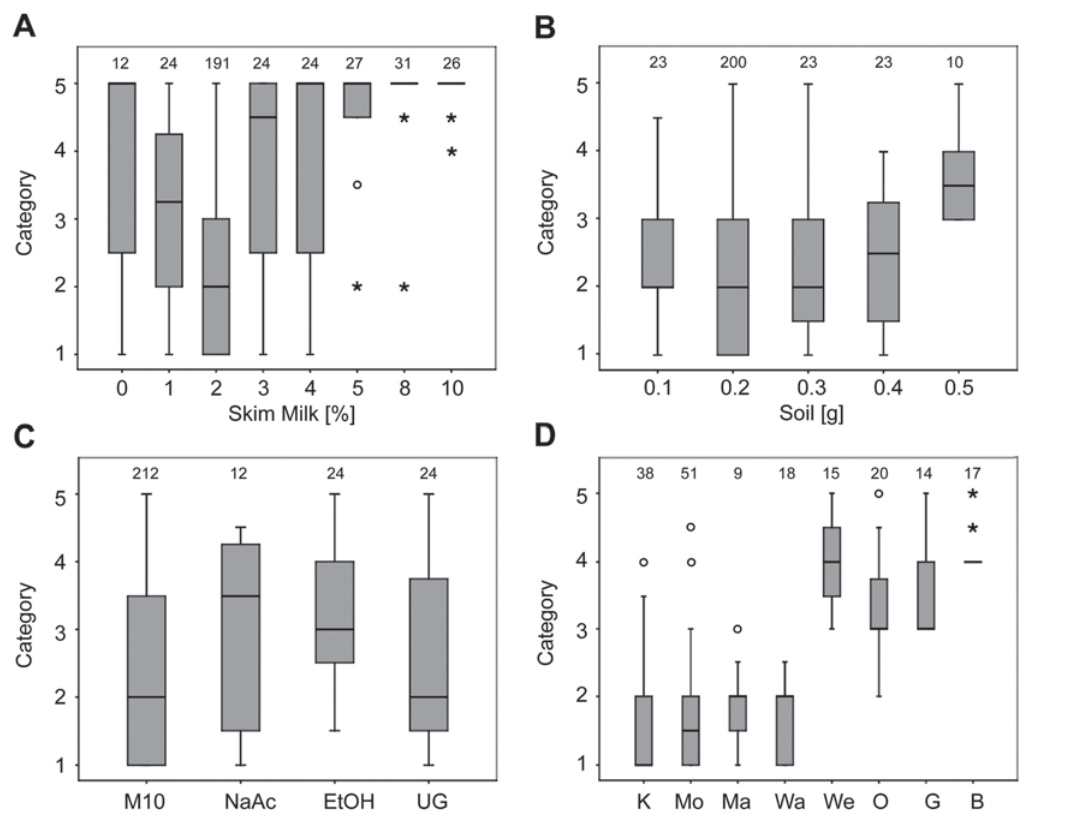
Fig. 2. Ratings of DNA extracts. A fi ve-point-scale was used, whereby category one was assigned to bands with the highest intensity. Data are expressed as a box-and-whisker plot showing median, inter-quartile range (IQR), and extreme values. Atypical outliers are indicated with an open dot (values 1.5–3×IQR), extreme outliners with an aste- risk (values >3×IQR). Numbers above the boxes represent the number of DNA extracts examined for each treatment. (A) Method 10, with varying concentrations of skim milk used in the extraction buffer. Percentages indicate the con- centration (w/v) of skim milk. (B) Amounts of soil extracted with method 10. (C) Method 10 compared with varying chemicals or soil treatments (M10, method 10; NaAc, sodium acetate instead of ammonium acetate; EtOH, ethanol instead of isopropanol; UG, unsieved soil). (D) Ratings of DNA extracts from different agricultural soils (K,